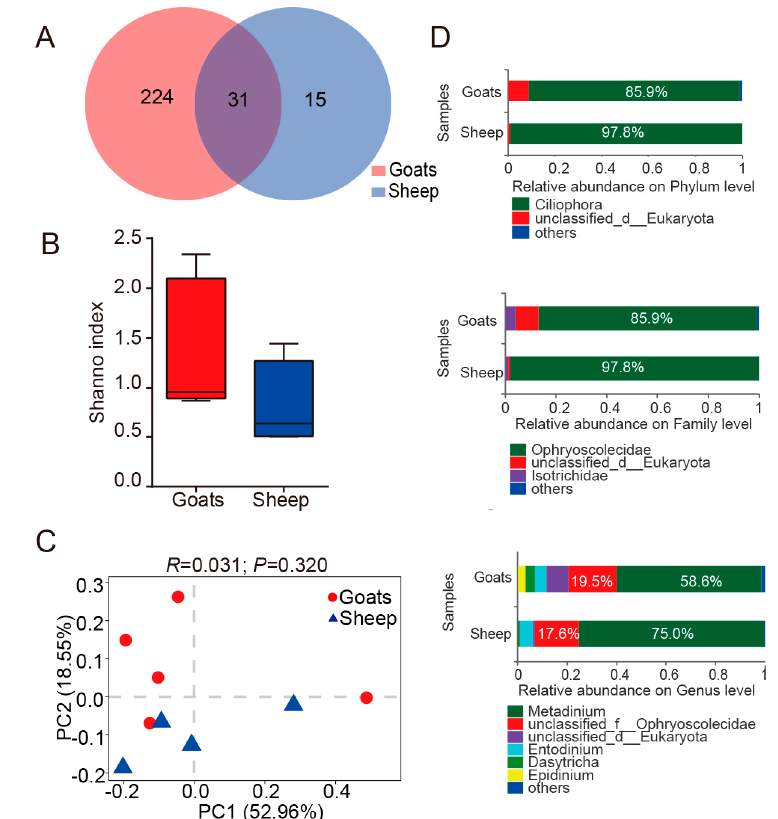
Figure 3. Diversity and composition of ruminal fungi in goats and sheep. ( A ). Mutual and particular operational taxonomic unit (OTU) number of protozoa in goats and sheep. ( B ). Comparison of the diversity estimation of the protozoa based on One-way ANOVA, in which the y -axis represented Shannon index. The Shannon index was related to the richness and evenness of the microbial community. ( C ). Principal coordinate analysis (PCoA) profile of protozoa diversity in all samples using an unweighted UniFrac metric. The percentage of variation explained by PC1 and PC2 were indicated in the axis X and Y. Statistic (R) and P-value (P) were annotated by ANOSIM analysis between goats and sheep. ( D ). The illustration exhibited the relative distribution of the most dominant protozoa (1% of the total sequences) in goats and sheep at the phylum, family, and genus level. 3.4 The concentrations of ruminal volatile fatty acids in goats and sheep.